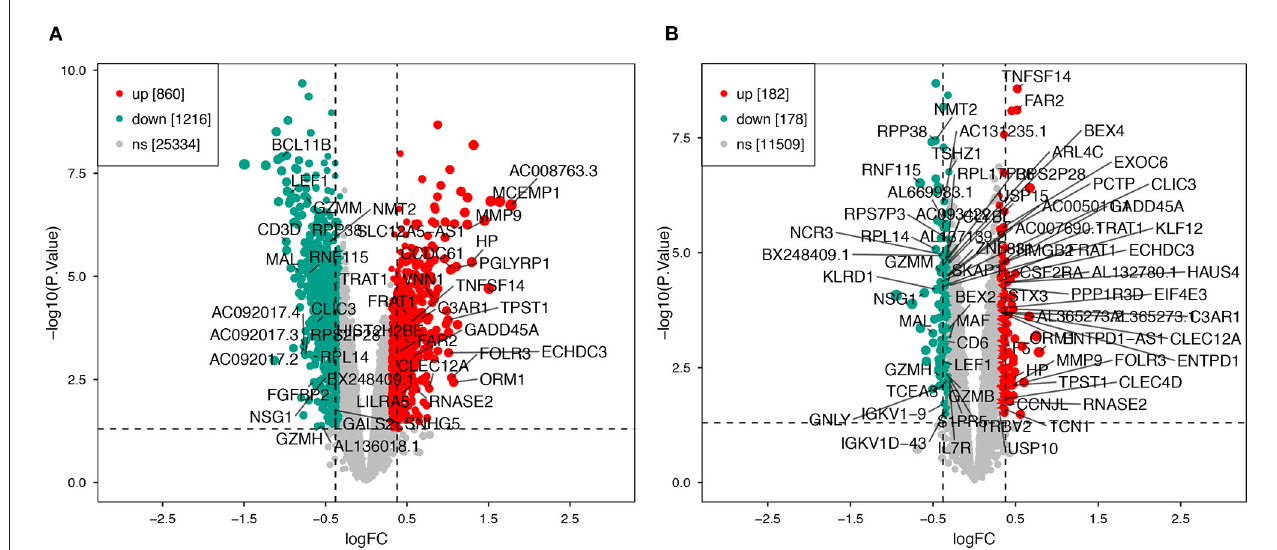
FIGURE2 Volcano plot of DEGs. (A) Extraction of related DEGs in SAH. (B) Extraction of related DEGs in epilepsy. Green and red represent downregulated and upregulated genes, respectively. SAH, subarachnoid hemorrhage.